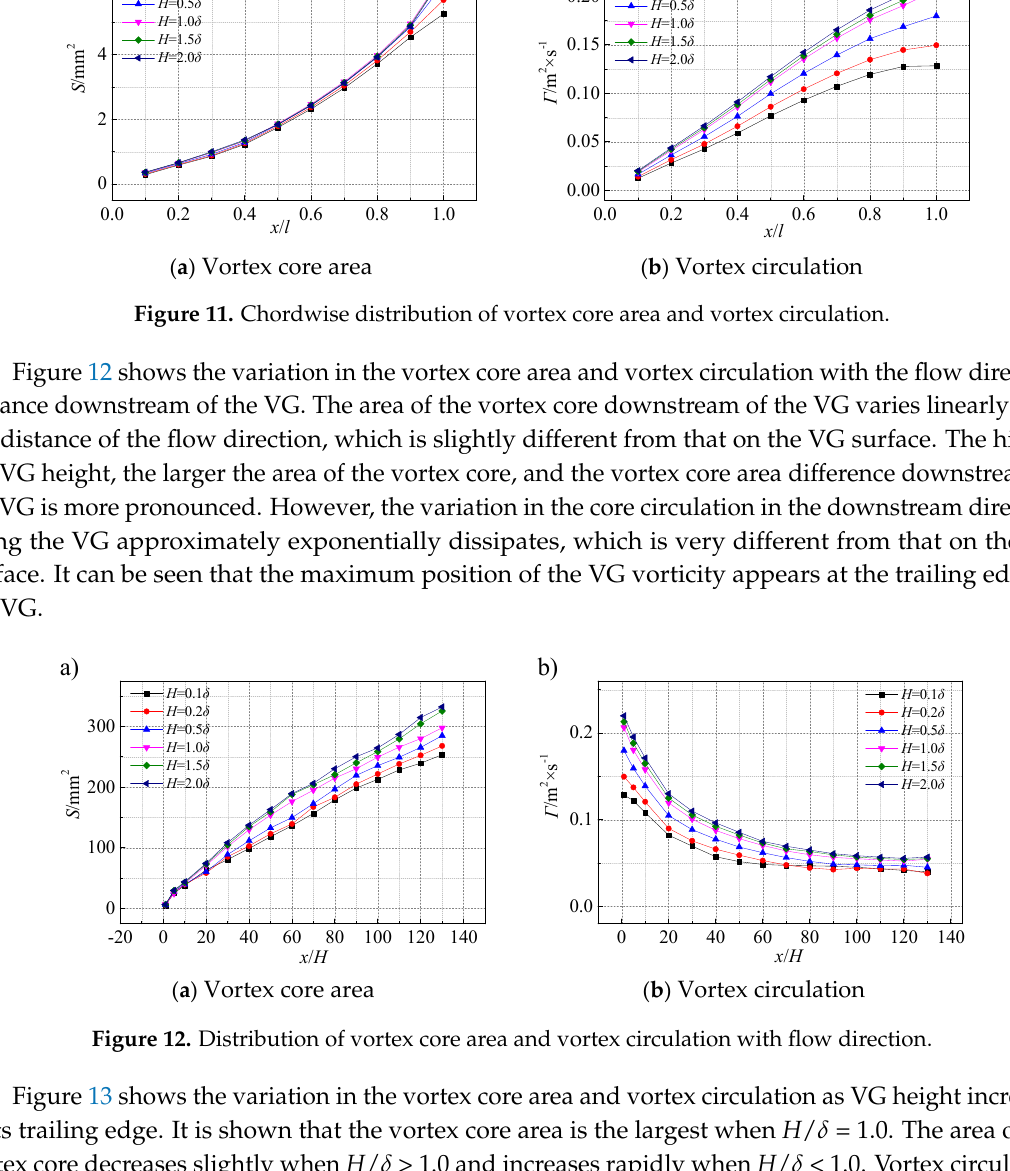
Figure 10. Distribution of static pressure coefficient at vortex core center.